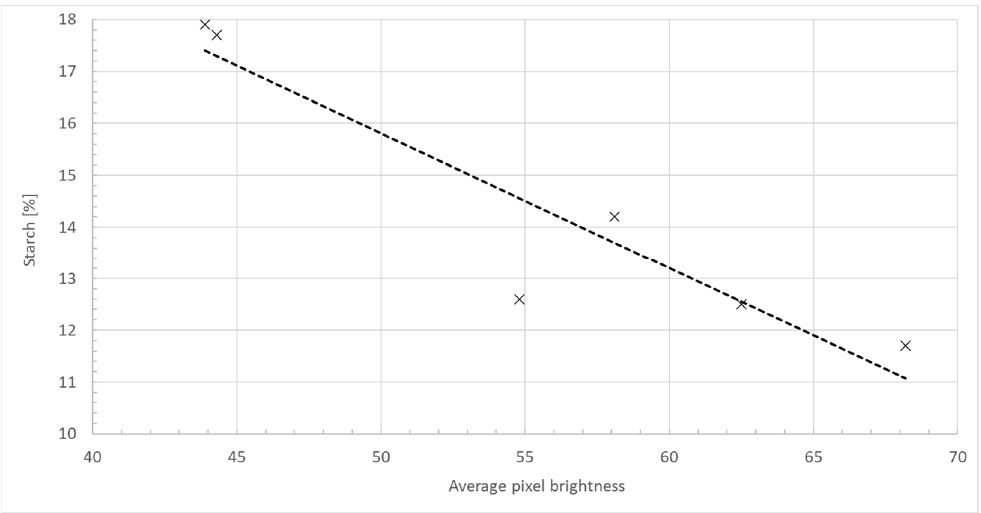
Figure 5. Dependence of starch contents of potatoes on mean pixel brightness assessed using digital image analysis, R 2 = 0.86.